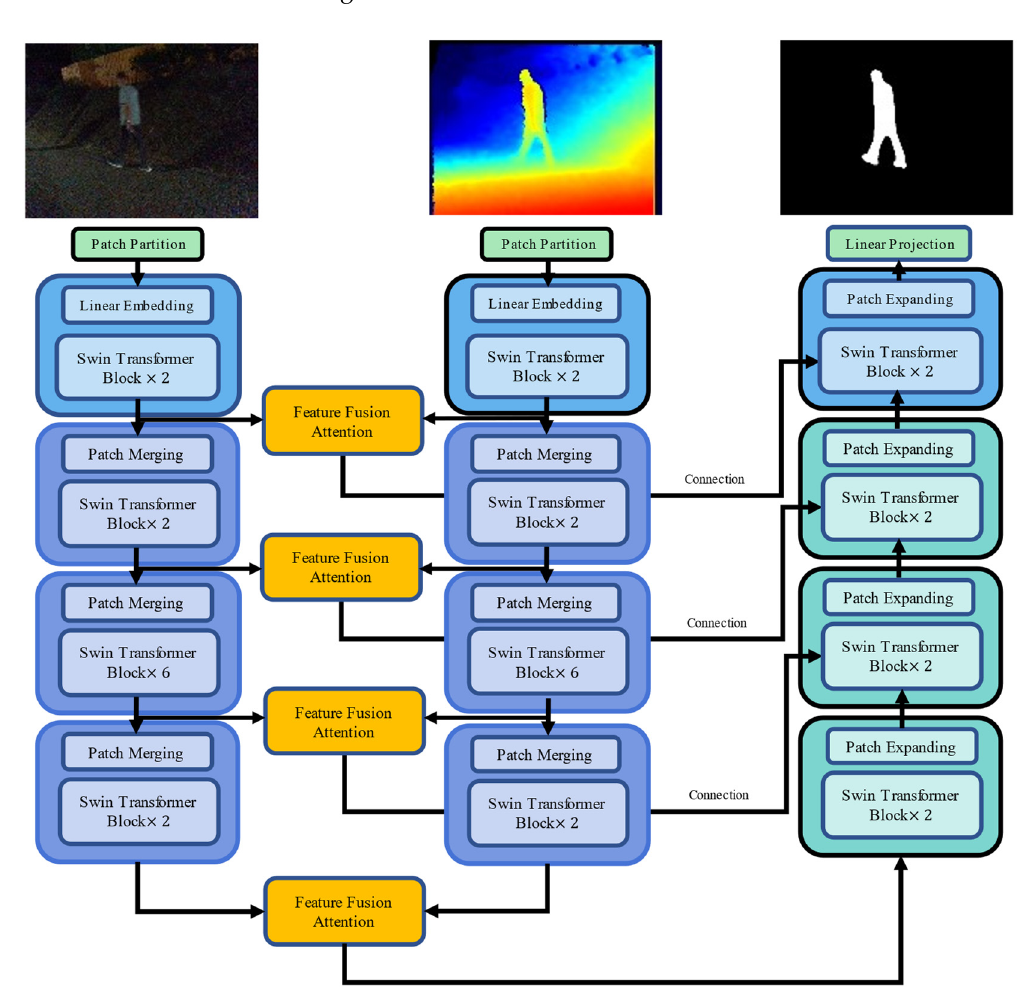
Figure 3. The structure of Swin-MFA network.